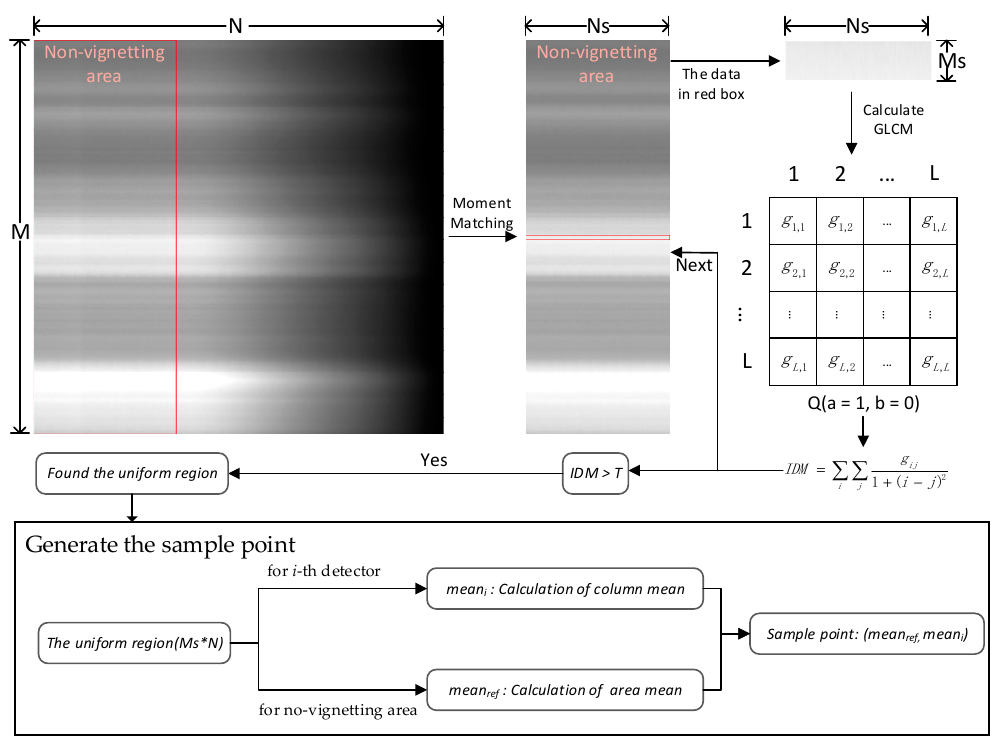
Figure 7. Process of the extraction of the sample points using the GLCM. IDM, inverse different moment. In the push-broom imaging mode, the satellite image noise is mainly streaking noise. Therefore, before the uniform area is determined, the streaking noise needs to be removed. Moment matching [31] employs the streaking noise removal algorithm based on the spatial domain. It assumes that the features detected by each detector have the same irradiance distribution. Then, the characteristics of the GLCM are used to identify regions of uniformity [32]. We require only that the region be uniform in the column direction, i.e., within data from a single detector. In addition, the GLCM describes the texture by studying the spatial correlation of grayscale areas. Therefore, it can be used to analyze the texture of a certain direction to determine the uniform region.